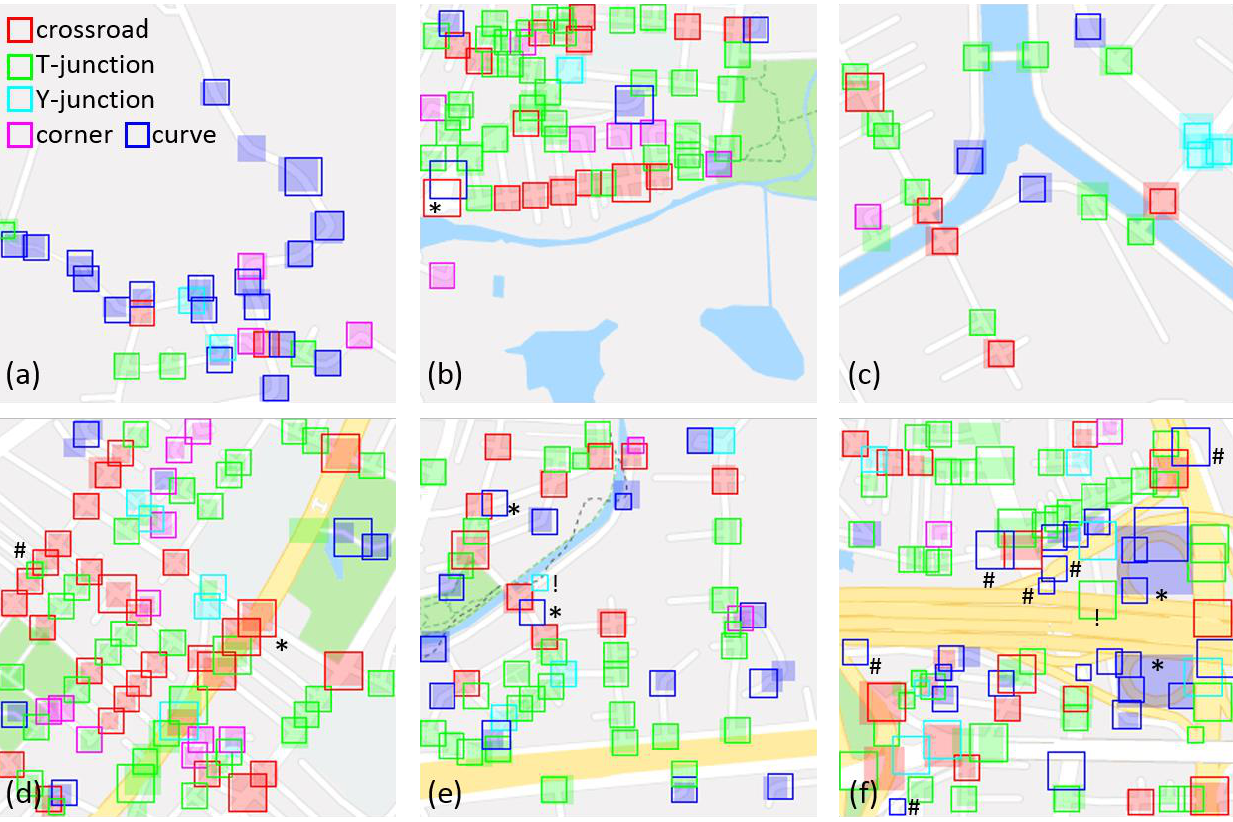
Figure 8. Our results overlaid on ground truth results that are marked as color-filled areas: ( a ) 54897_28039_16, ( b ) 54880_28041_16, ( c ) 54876_28052_16, ( d ) 54873_28067_16, ( e ) 54908_28051_16, and ( f ) 54888_28049_16.